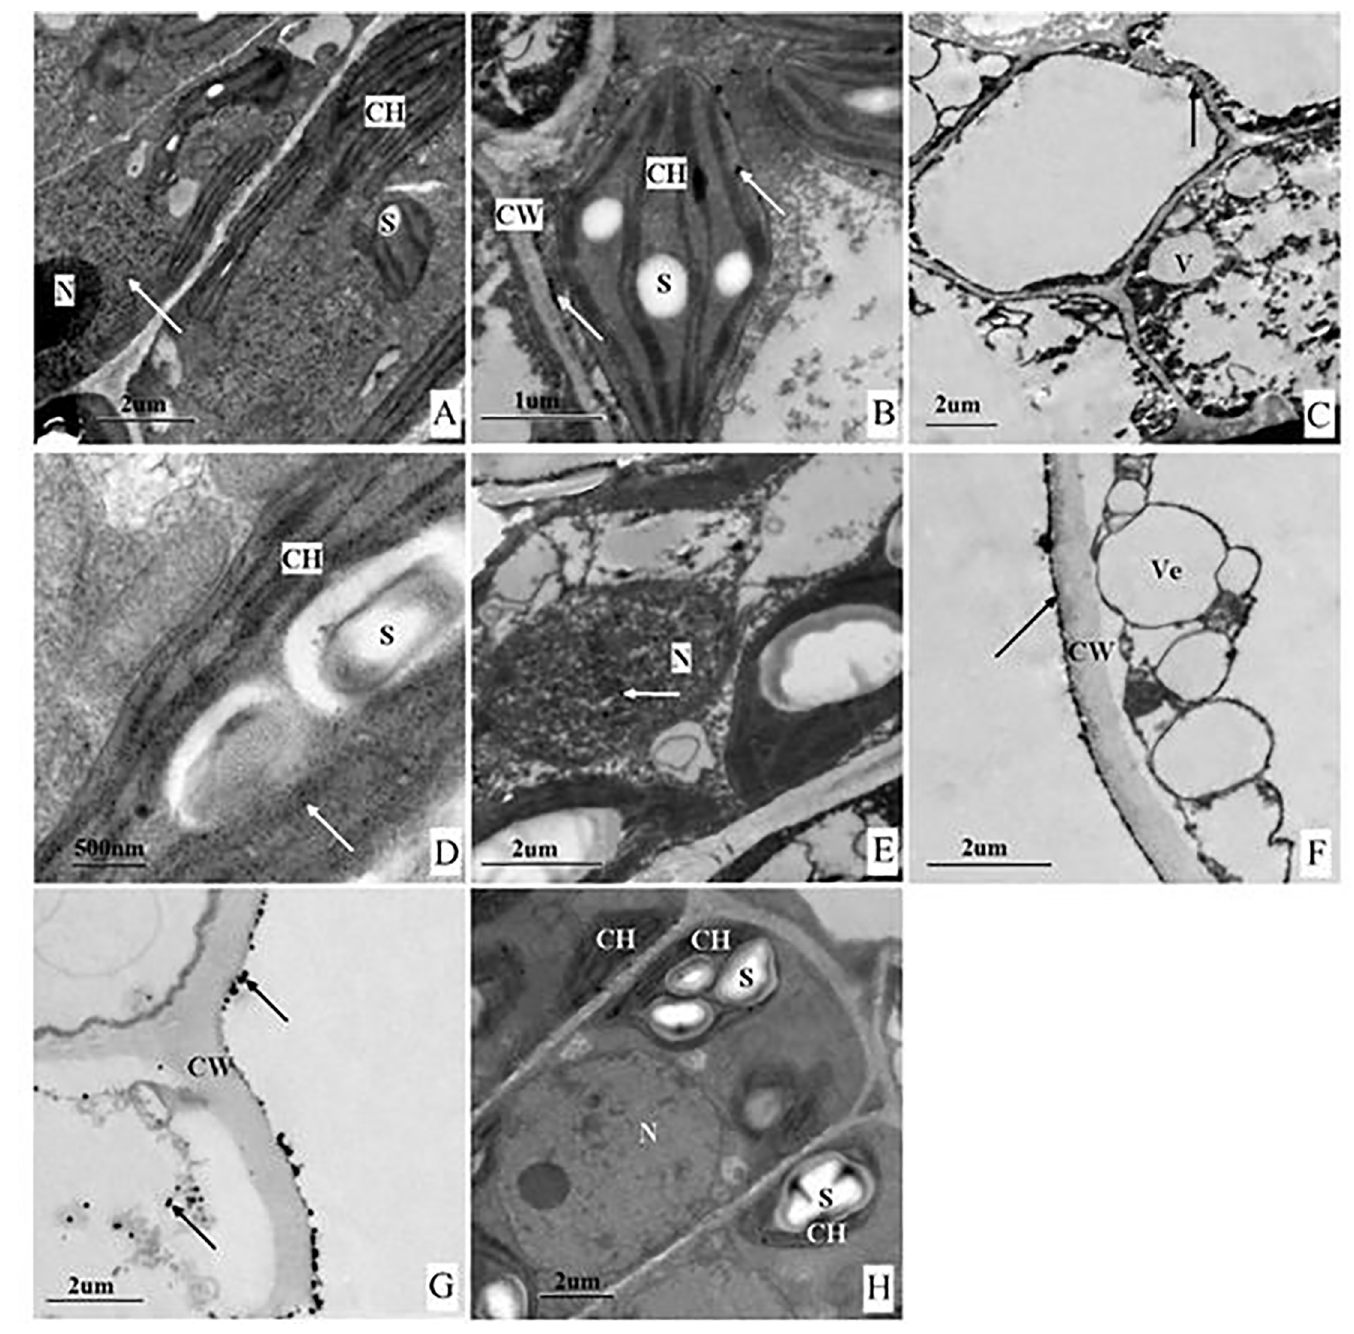
Fig 2. Cytochemical localization of saponins in leaves of C . paliurus . Saponin precipitations is black masses indicated with an arrow. ( A ) Nucleus (young leaf); ( B ) Chloroplast (young leaf); ( C ) Epidermal cell (young leaf); ( D ) Chloroplast (mature leaf); ( E ) Nucleus (mature leaf); ( F ) Vesicle and plasmalemma (mature leaf); ( G ) Epidermis cell wall and the cytoplasm (mature leaf); ( H ) Control with no saponins precipitations. CH, Chloroplast; CW, Cell wall; N, Nucleus; S, Starch grains; V, Vacuole; and Ve,